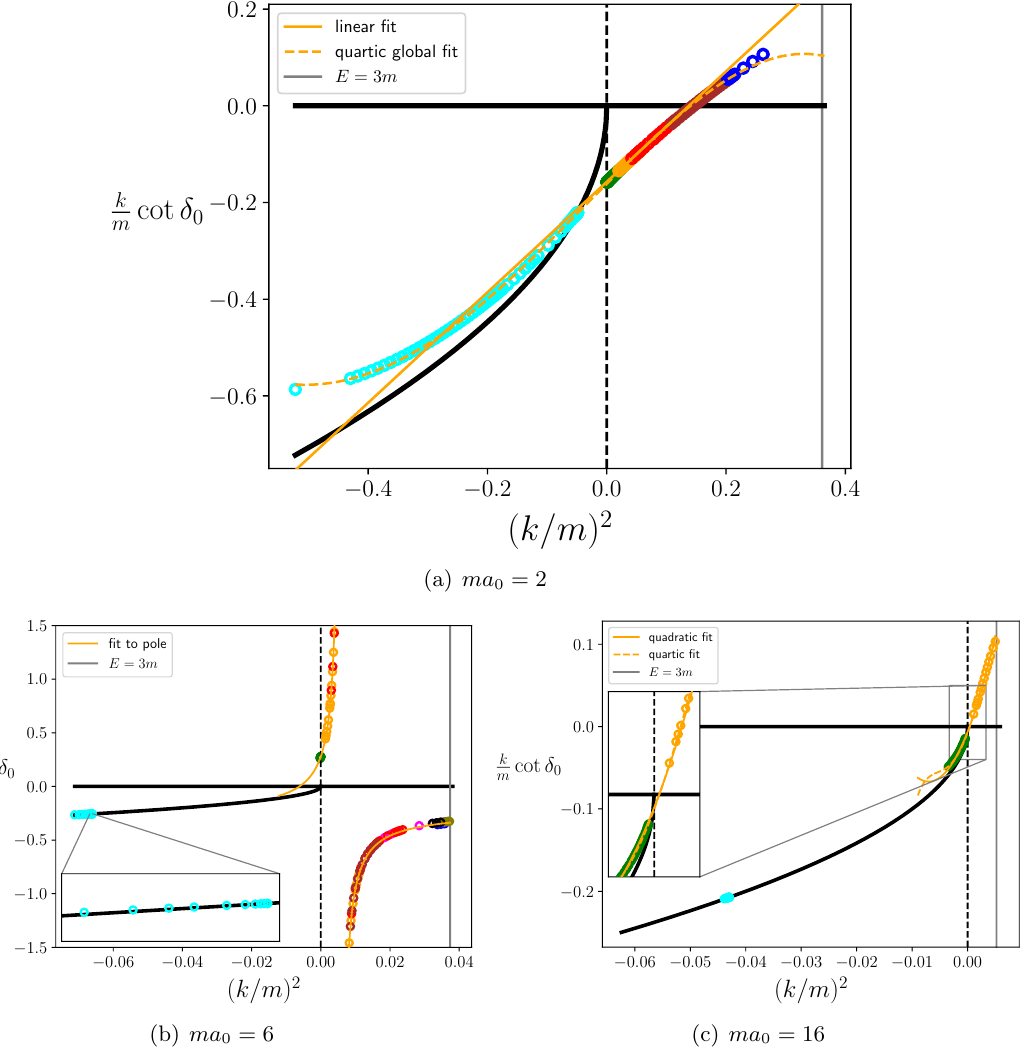
Figure 7 . k cot (cid:14) 0 ( k ) for particle-dimer scattering as a function of the relative center-of-mass momentum k , as determined from the three-particle (cid:12)nite-volume spectrum in the 2 + 1 regime using eq. (4.8). We set K iso = 0 throughout, and consider three di(cid:11)erent choices of ma 0 . Di(cid:11)erent df ; 3 colors represent data points coming from di(cid:11)erent states in the spectrum, and there is considerable overlap of points for k 2 > 0. The solid vertical line near the right-hand edge of each plot shows the value of ( k=m ) 2 corresponding to the three-particle threshold, i.e. E = 3 m . The curved solid (cid:0)p line for negative k 2 shows (cid:0)j k j = (cid:0) k 2 . A bound state is present whenever k cot (cid:14) 0 ( k ) passes through this line. The (cid:12)ts and other aspects of the plots are described in the text.